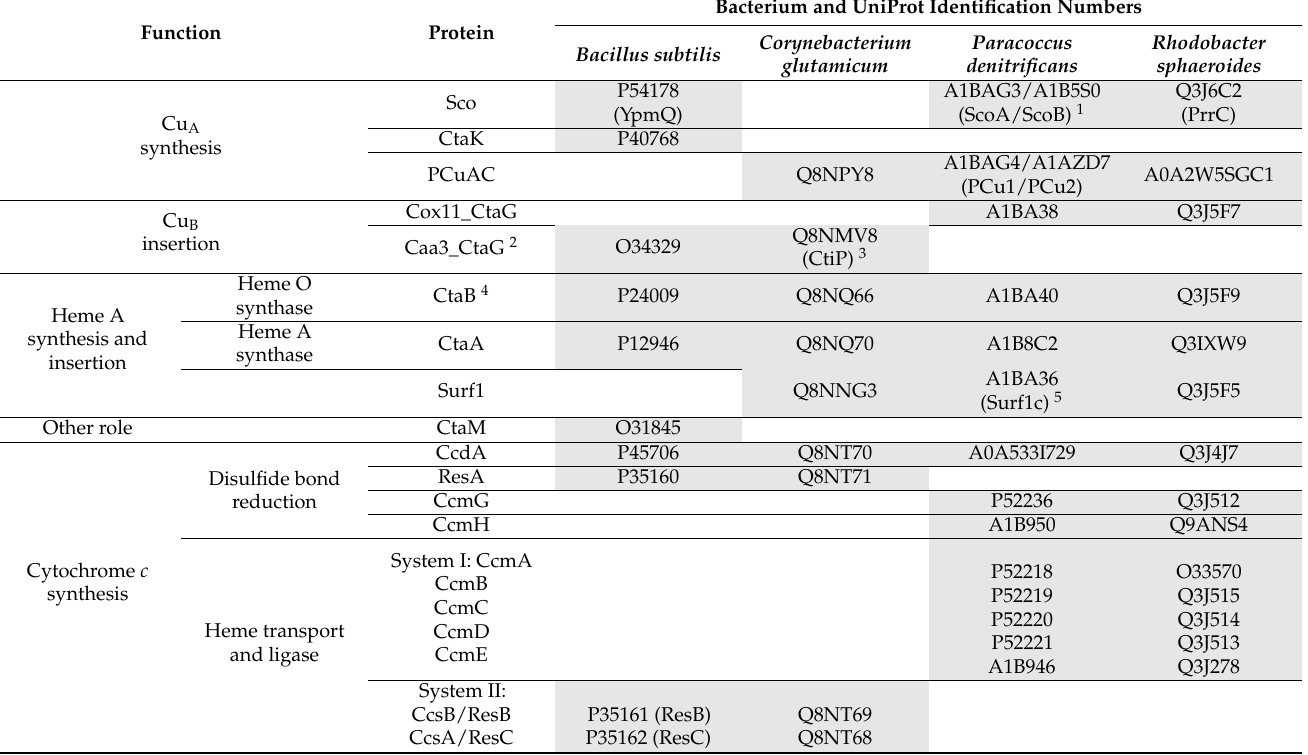
Table 1. Diversity and occurrence of proteins identified to function in cytochrome c oxidase biosyn- thesis in four bacteria. The color background quickly brings an overview on the occurence of the different proteins among the four bacteria. The UniProt identification numbers bring a second layer (more detailed) of